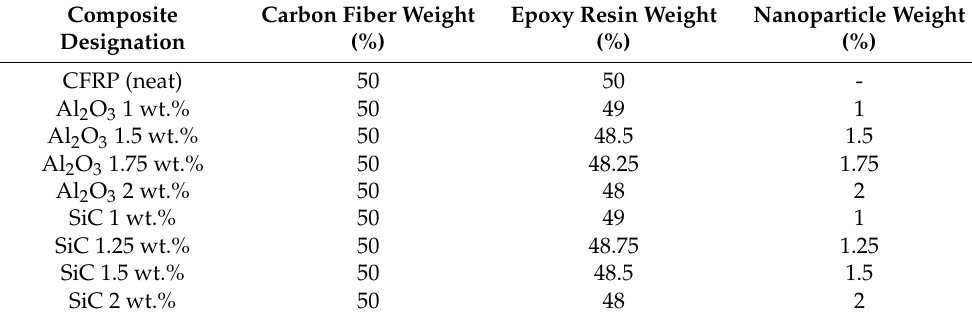
Table 4. Composition of neat and hybrid